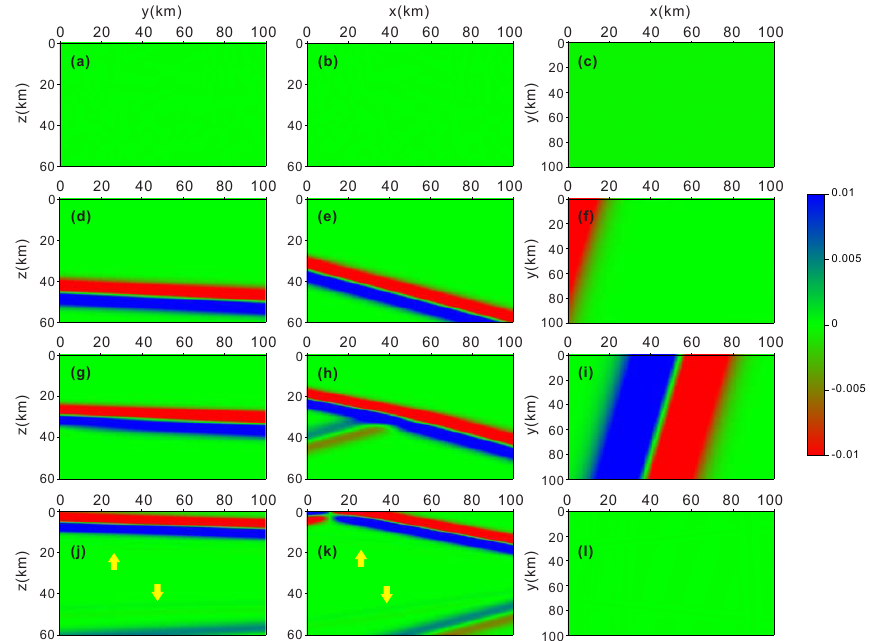
Figure 3. Plane-wave incident on a 1-D crust–upper-mantle model. The snapshots from the top to the bottom are taken at t = 10, 16, 18, and 22s, respectively. The left, middle, and right panels are corresponding to snapshots of planes at x = 50km, y = 50km, and z = 30km, respectively. The yellow arrows in (j) and (k) denote the weakly transmitted and reflected S waves. The color scale is shown on the right side of the figure.